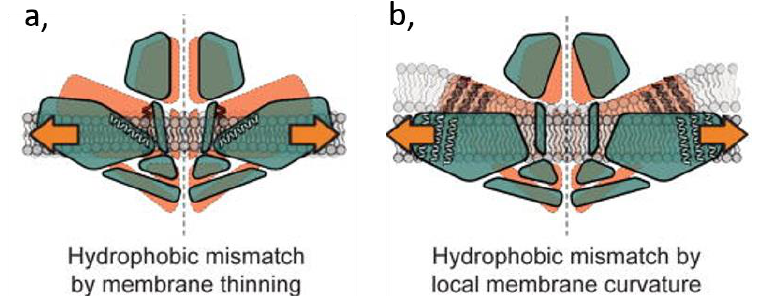
Figure 7. Two of the proposed gating mechanisms for Piezo channels. Alterations of the membrane thickness originating from membrane thinning ( a ) or reduced curvature through stretching ( b ) result in hydrophobic mismatch and adaptive changes of Piezo conformation. Reproduced from [305].